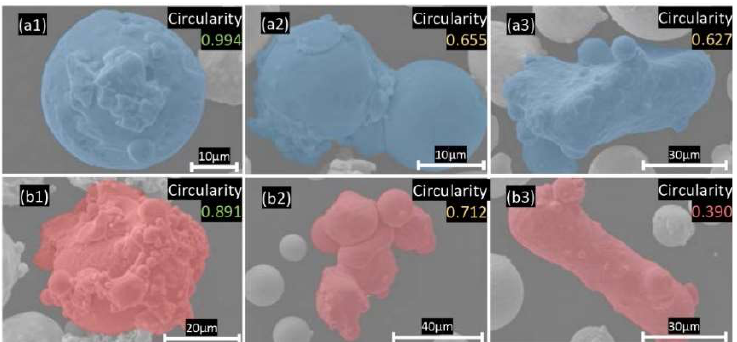
Figure 3. Typical morphology of non-spherical powder particles from SEM, ( a1 – a3 ) virgin powder with ( a1 ) near spherical particle with satellites on surface; ( a2 ) agglomerated particle; ( a3 ) elongated particle, and ( b1 – b3 ) reused powder with ( b1 ) near spherical particle with satellites on surface, ( b2 ) particles agglomerate, ( b3 ) elongated particle.